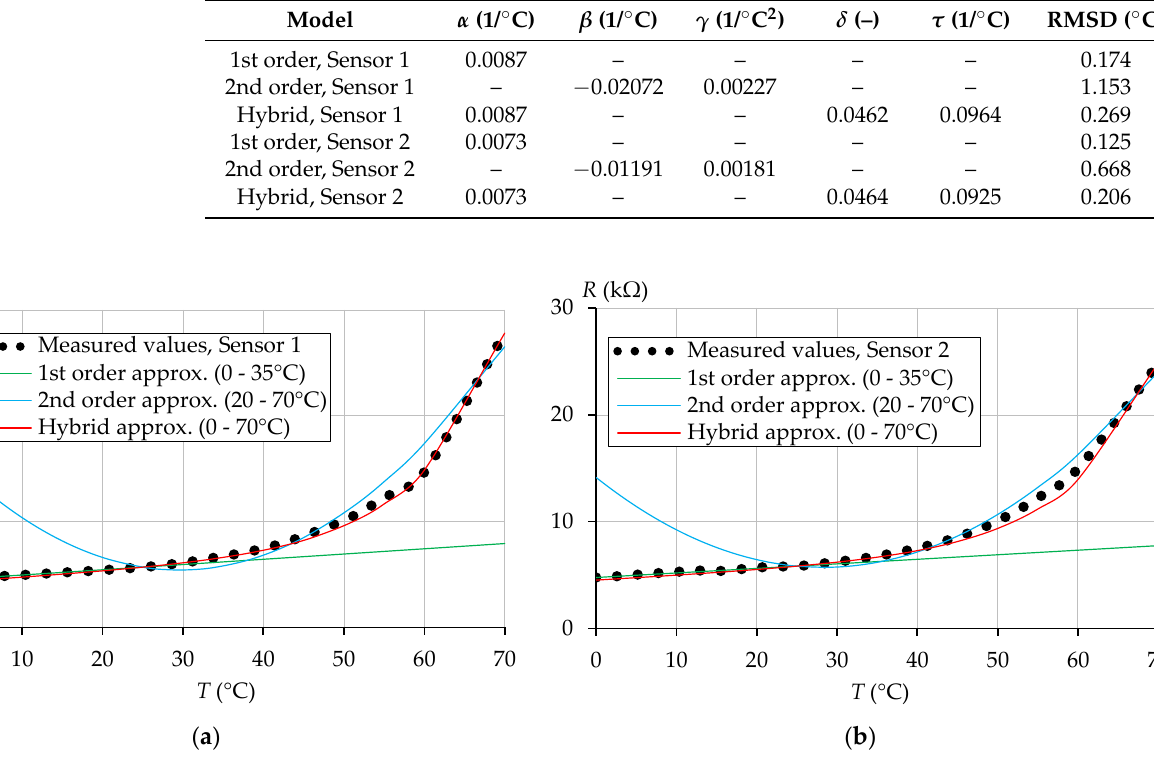
Figure 9. The measured and approximated by analytical models temperature dependence of the resistance for: ( a ) the Sensor 1 and ( b ) the Sensor 2.